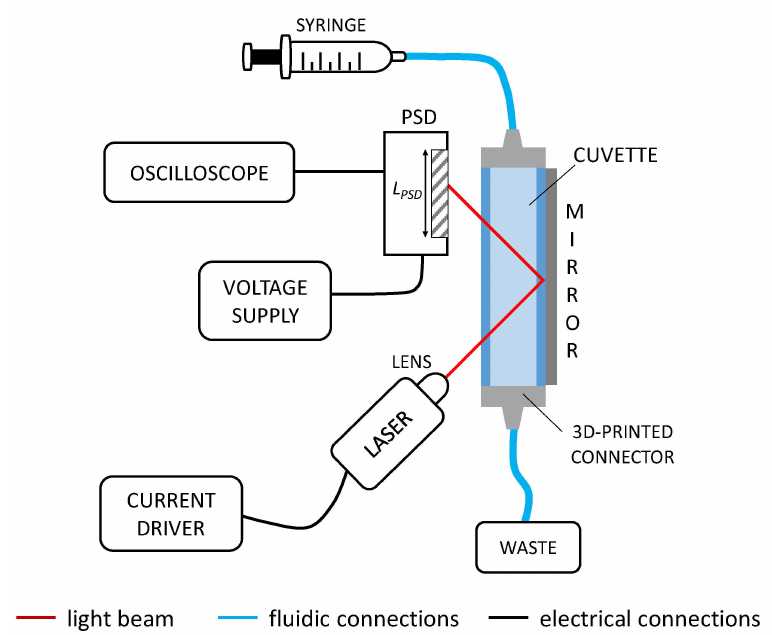
Figure 2. Optofluidic instrumental configuration of the sensing platform. PSD: Position Sensitive Detector.